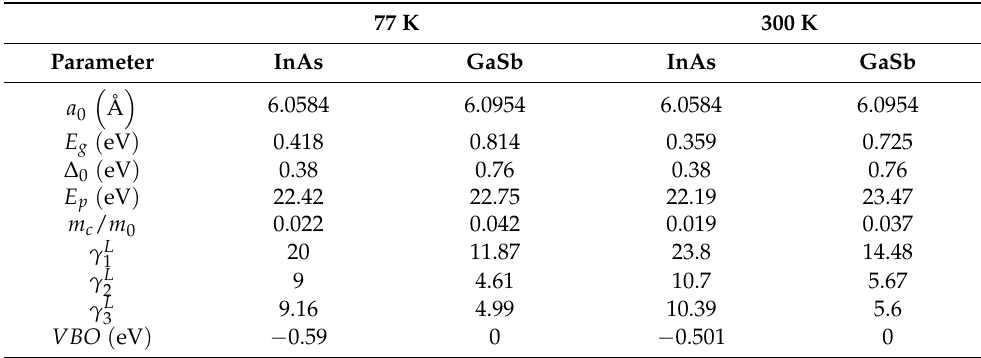
Table 1. Material parameters for calculations at 77 and 300 K are adopted from